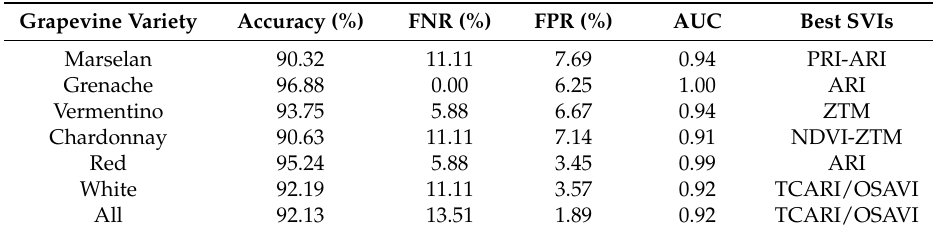
Table 6. Results of using the best SVIs in classifying different groups of spectral data acquired in the August acquisition campaign (Severity of infestation = 1).